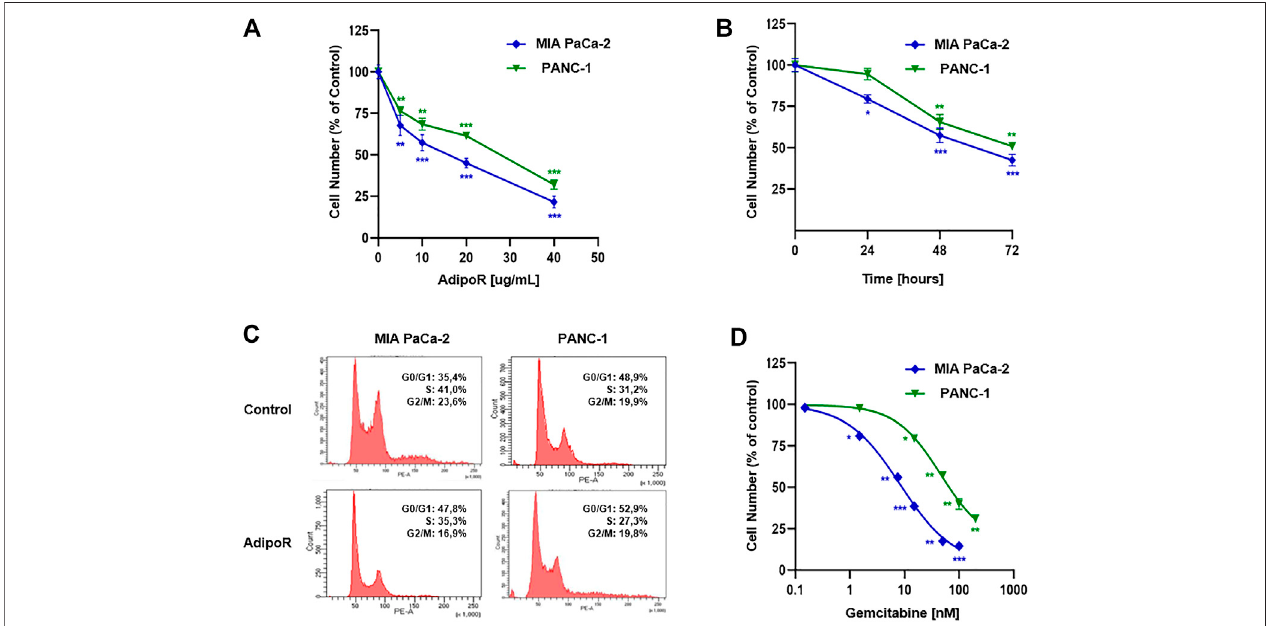
FIGURE 1 | Evaluation of single drug-mediated effects in PDAC cells. (A) MIA PaCa-2 and PANC-1 cells were exposed for 48 h to increasing AdipoR concentrations (10 – 40 µg/ml). (B) Cell growth curves were established in reaction to 10 µg/ml AdipoR over a period of 72 h. (C) Representative cell cycle pro fi les were obtainedinMIAPaCa-2andPANC-1cellstreatedandnot(control)with10 µg/mlAdipoRfor24 h. (D) Doseeffectinducedby48 hofGemadministrationinMIAPaCa-2 and PANC-1 cells. In each experimental condition, the relative cellnumber wasestimated intriplicate and expressed in fi gure as%ofcontrol. * p < 0.05, ** p < 0.01, *** p < 0.001 by unpaired Student ’ s